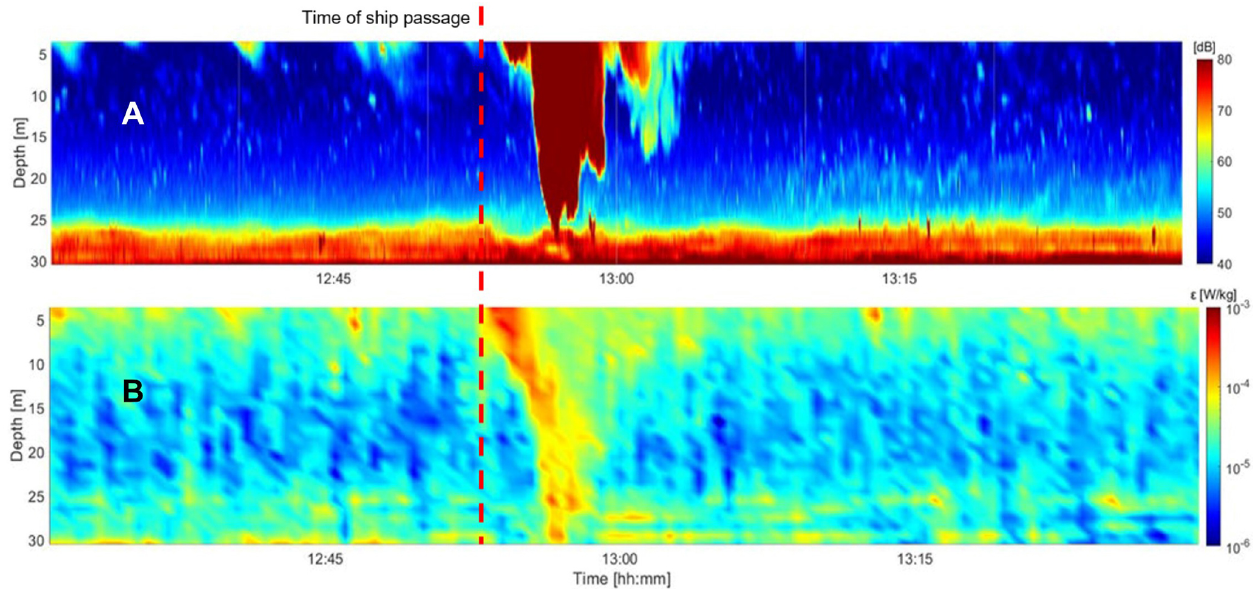
Figure 3. Example of the bubble wake signal in the echo amplitude dataset (a) and the calculated dissipation rate of turbulent kinetic energy, ε , (b) from 1h of ADCP measurements. The upward-facing ADCP was placed at 32m depth, repeatedly measuring the water column at one point. The dashed red line marks the time of ship passage. The high-intensity red (a) and yellow (b) areas after the ship passage represent the wake region. The increase in ε down to the bottom is evidence of increased turbulence and a vertical mixing down to 30m depth. The wake was induced by a cargo ship (width 25m, length 229m, draught 7m), which passed the instrument at a distance of 34m and a speed of